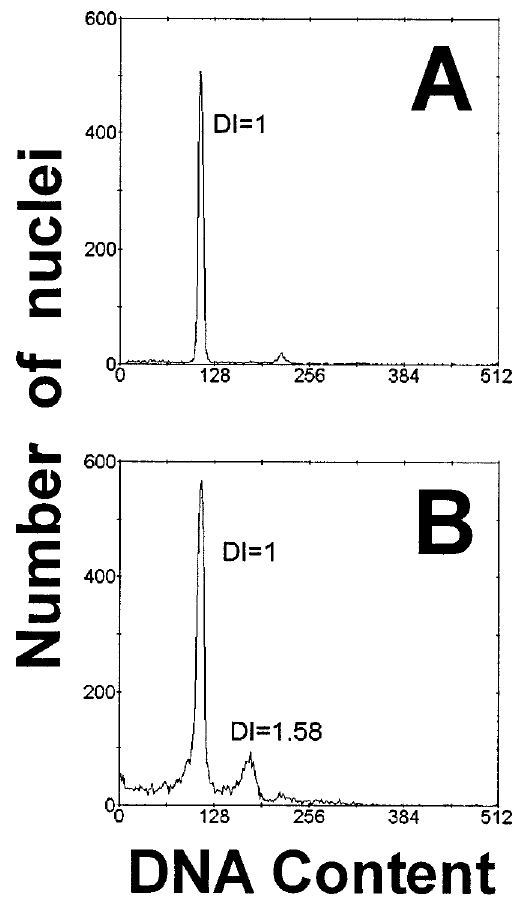
Fig. 1. Examples of DNA content analysis of two FAP adenoma sam- ples by flow cytometry (see the text Result